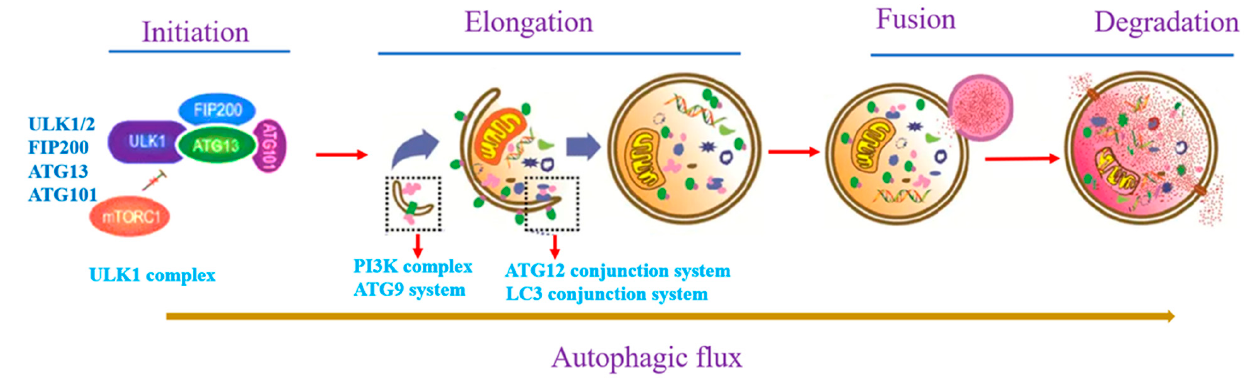
Figure 1. Patterns of autophagic flux, which is composed of autophagy initiation, elongation, and degradation, and every process is regulated by many autophagy-related genes, such as ATG13, ATG12, and LC3.